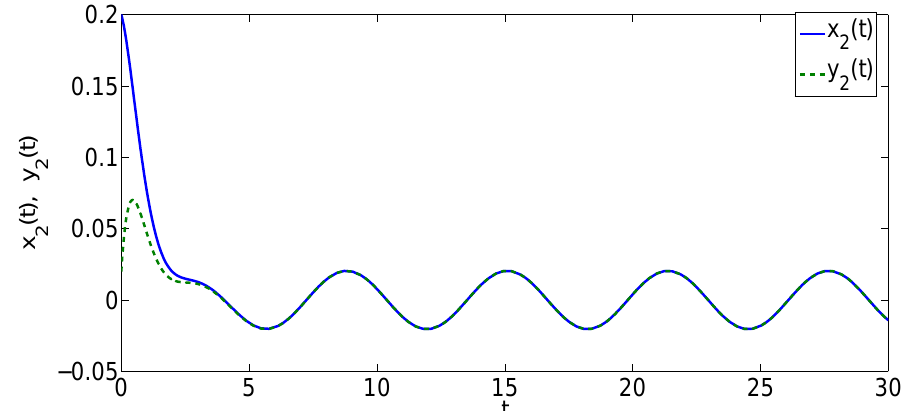
Figure 5. The synchronization trajectories between the state x 2 ( t ) of the drive system in Equation (32) and the state y 2 ( t ) of the response system in Equation (33) in Example 2.